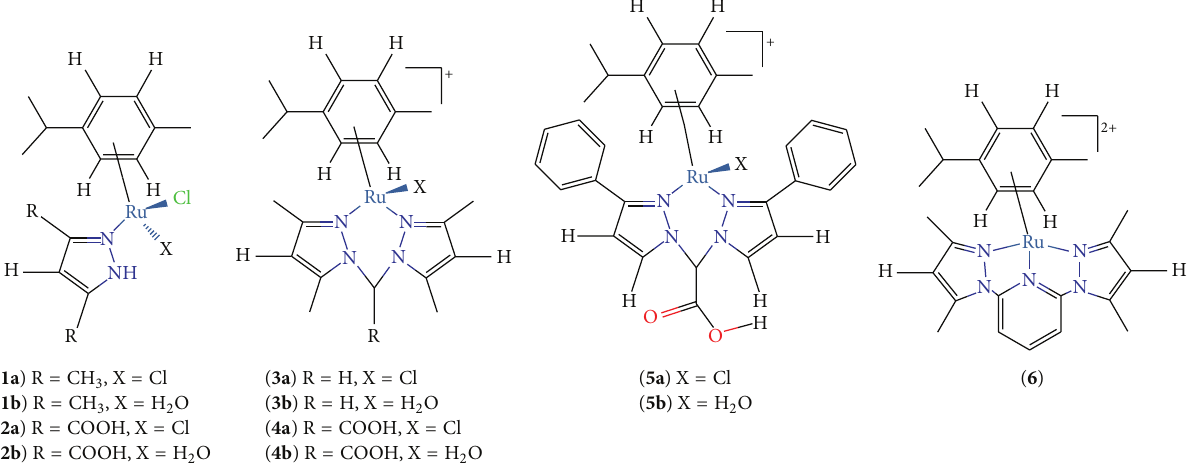
Figure 1: The molecular representation of 𝜂 6 -cymene (Cym) ruthenium(II) derivatives of 3,5-dimethylpyrazole ( 1a ), 3,5-diaceticpyrazole ( 2a ), bis(3,5-dimethylpyrazol-1-yl)methane ( 3a ), bis(3,5-dimethylpyrazol-1-yl)acetic ( 4a ), bis(5-phenylpyrazol-1-yl)acetic ( 5a ), and bis(3,5- dimethylpyrazol-1-yl)pyridine ( 6 ) complexes with their hydrated forms. The explicit hydrogen atoms shown are of